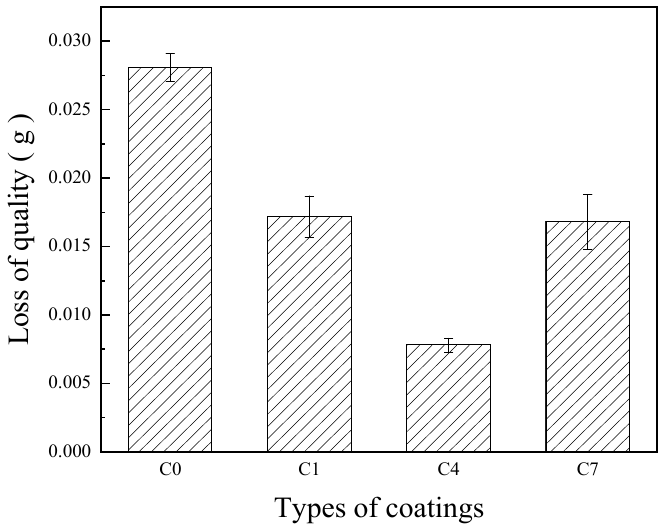
Figure 1. Mass loss of WPU-modi fi ed coatings after wear resistance